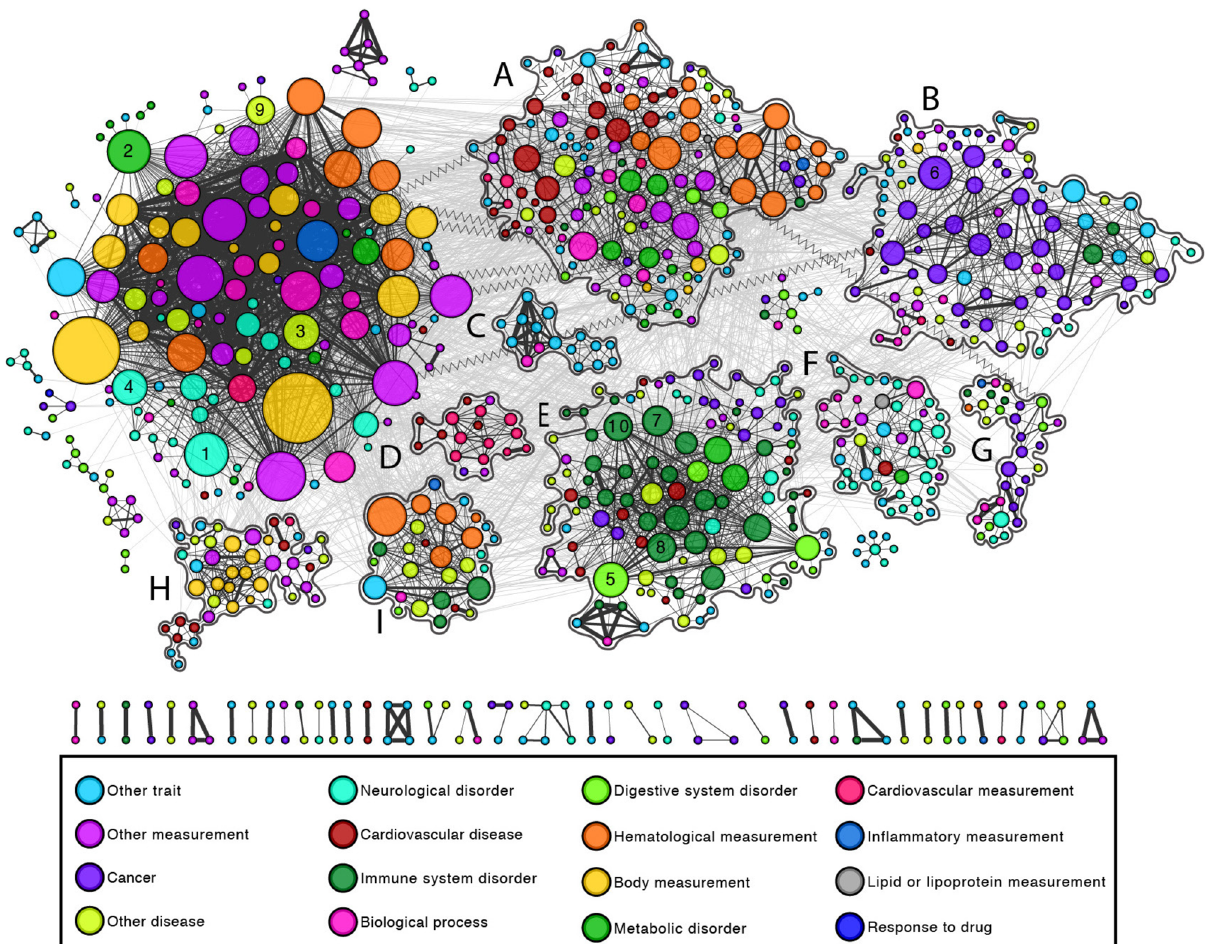
Figure 1. Phenotypic network assembled from GWAS catalog. Network in which nodes are traits that are connected with others to which they share genetic variants in the GWAS Catalog. The network communities detected are highlighted and labeled ( A )–( H ). Node colors represent disease categories and node size reflects connectivity in the network. The top high degree nodes are labeled 1–10 and their respective names are shown in Table 1. Only significant edges are shown (FDR < 0.05), the edge width indicates the overlap of variants between a pair of phenotypes (Jaccard Index), and lighter shade edges connect nodes in different communities.